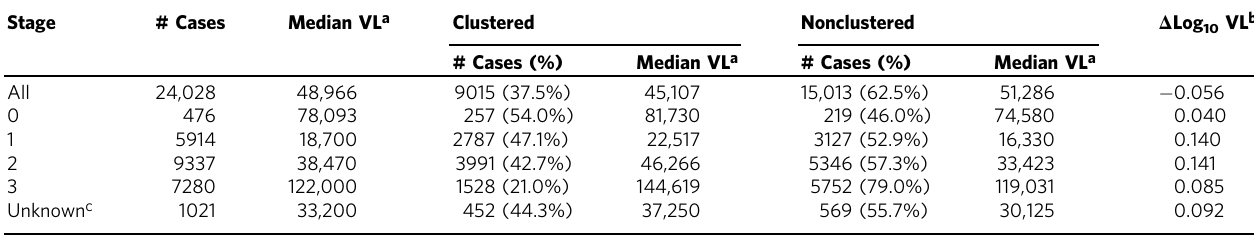
Table 1 Median viral load (VL) in clustered and nonclustered individuals at different stages of HIV infection at diagnosis in people with wild-type virus, United